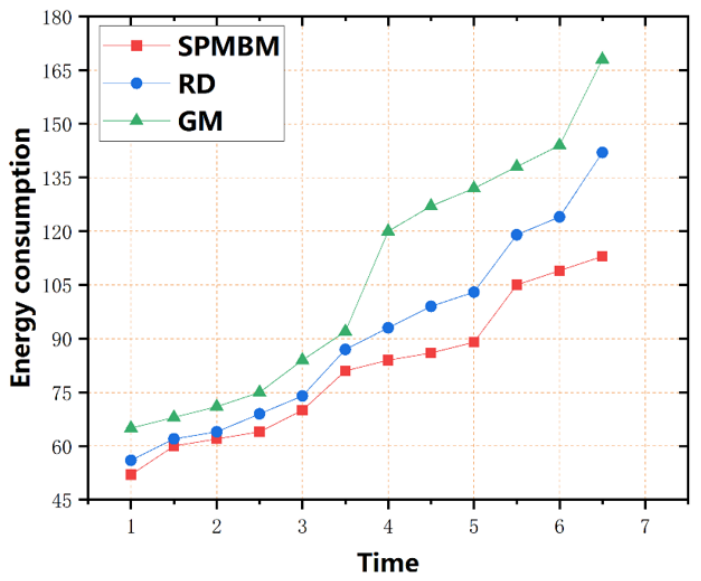
Figure 8. Relationship between transmission success ratio and time in three mobility models.